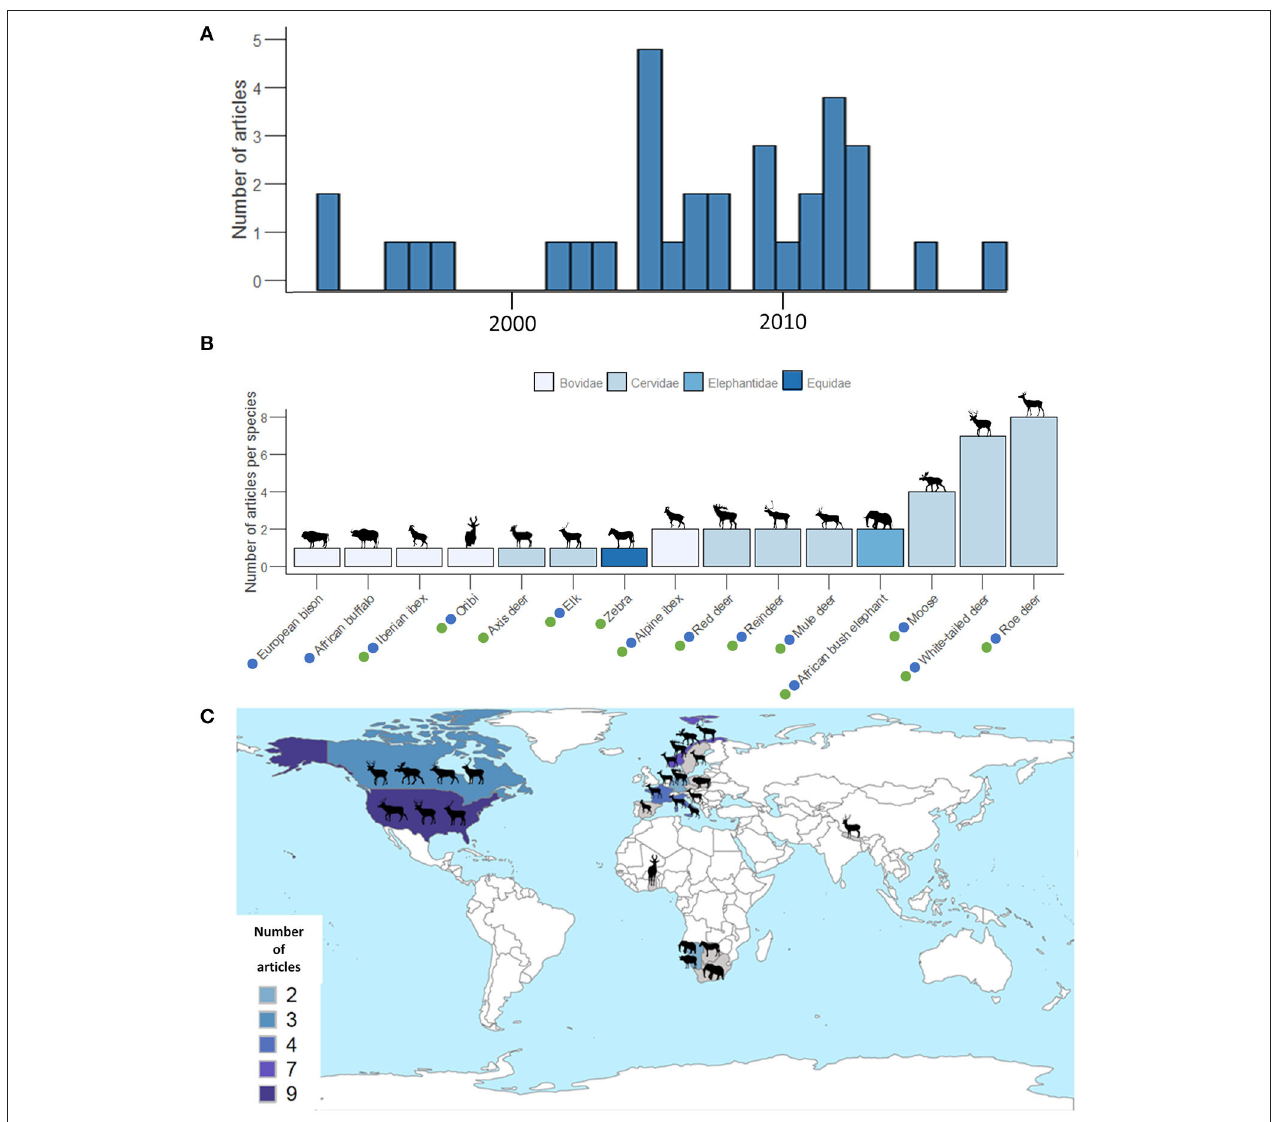
FIGURE 3 | (A) Number of articles published each year. (B) Number of articles per species. Dots depict species for which we were able to retrieve information on seasonal relationships between the sizes of home ranges and biomass of vegetation during the productive (green dots) and non-productive (blue dots) periods and retained in the final comparative analysis (see PRISMA; Figure 2 ). (C) Map of the countries where studies took place. Numbers of publications per country are indicated by different